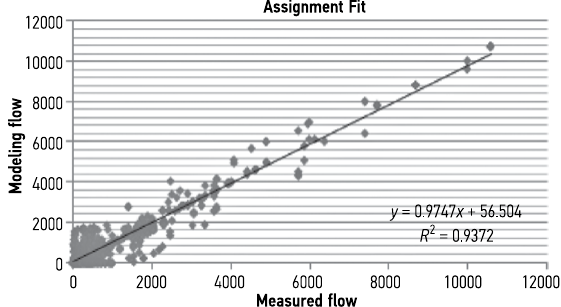
Fig. 7. Fit between modelled flows and real flows